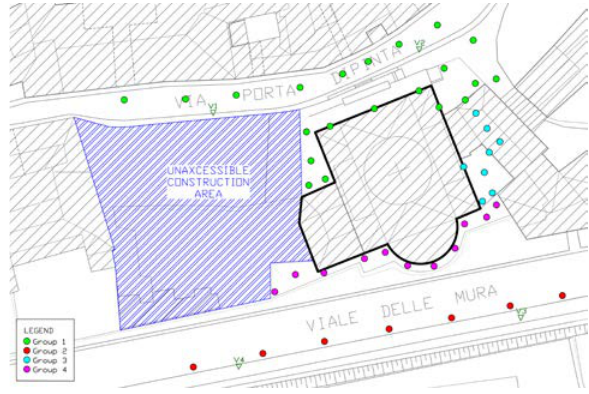
Figure 3. External positions for laser scanning acquisition.